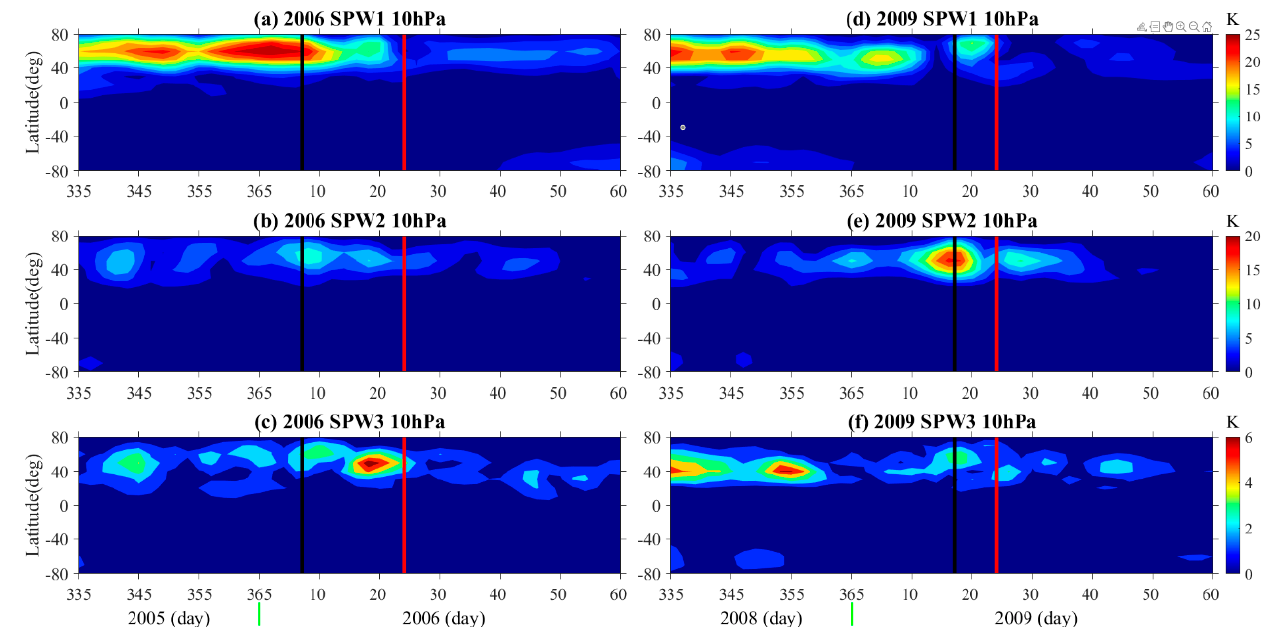
Figure 5. Temporal and latitude variations of the stationary planetary wave with wavenumber 1 (SPW1), 2 (SPW2), and 3 (SPW3) at 10 hPa in 2006 ( a – c ) and 2009 ( d – f ). The vertical black and red lines indicate the starting of the sudden stratospheric warming and the warming peak of the sudden stratospheric warming.